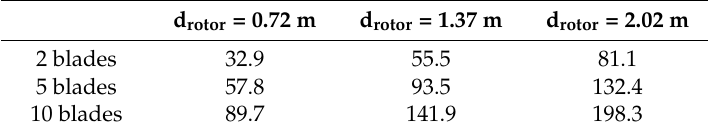
Table 2. Mean power output in Watts for various rotor diameters and various numbers of blades. d rotor = 0.72 m d rotor = 1.37 m